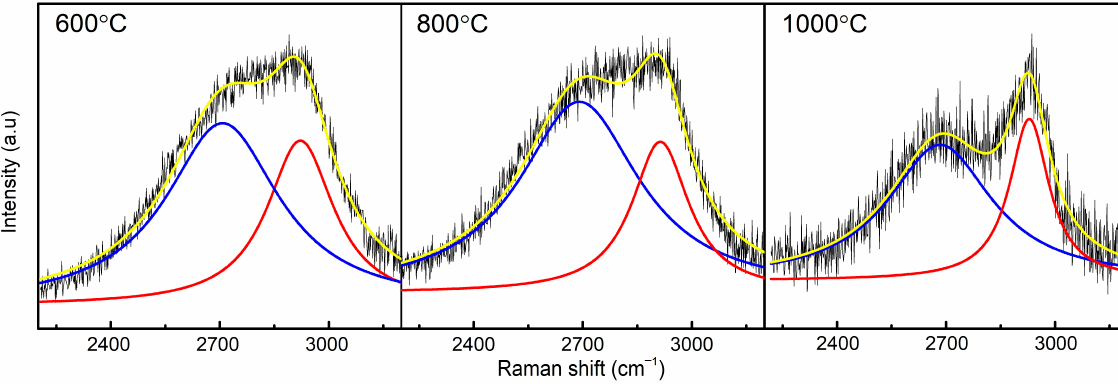
Figure 2. Fitted second—order Raman spectrum of samples sintered at 600, 800, and 1000 °C.